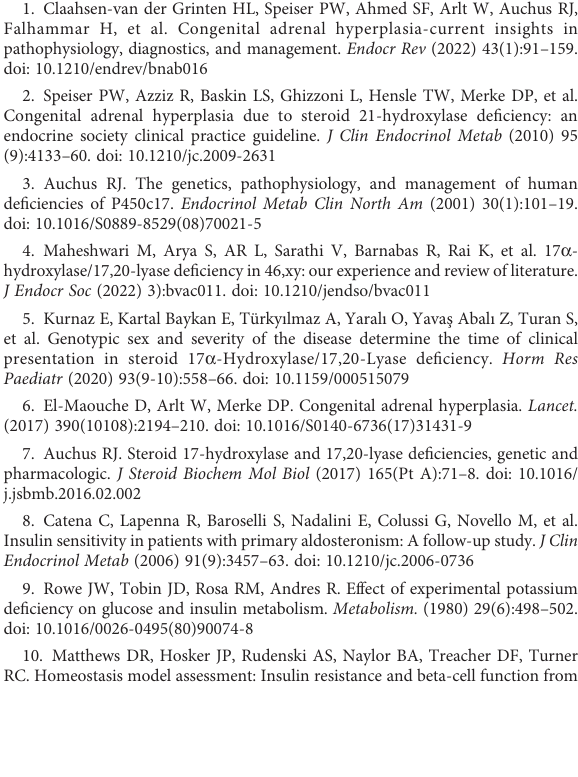
SUPPLEMENTARY TABLE 2 Clinical characteristics of the 11 patients with hyperglycaemia followed up to 30 years and older. IGT: impaired glucose tolerance; DM: diabetes